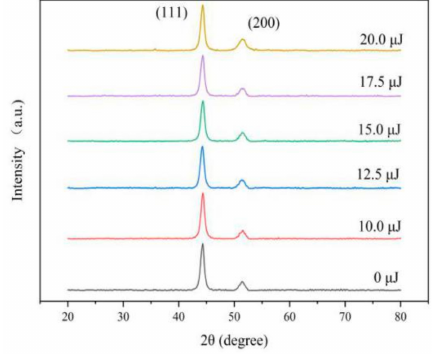
Figure 5. XRD pattern of coatings with varying laser